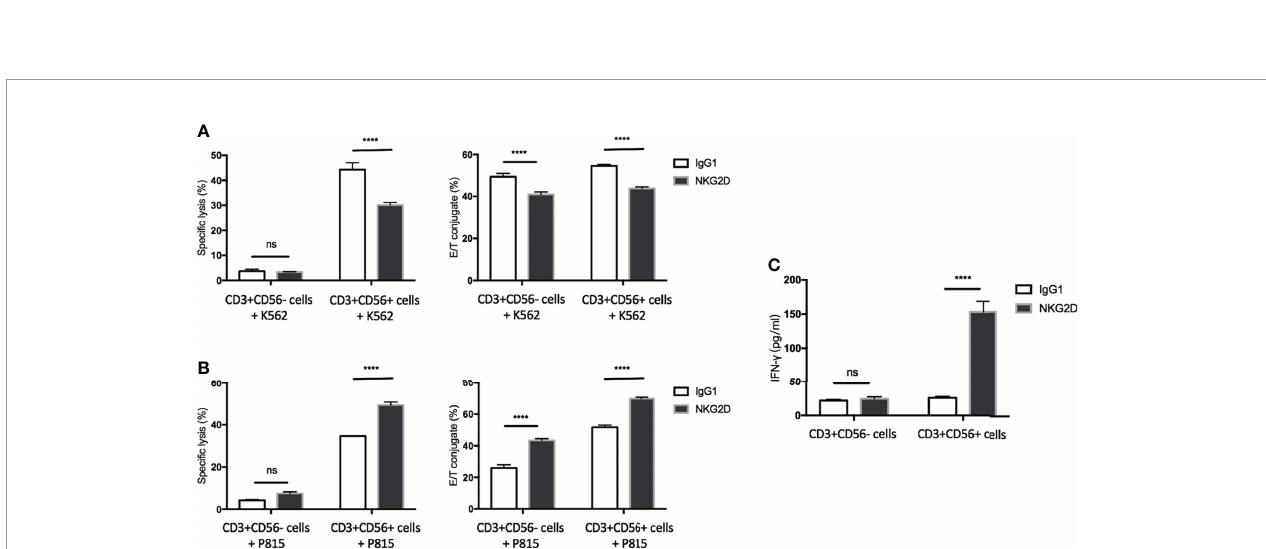
FIGURE 4 | NKG2D contributes alone to degranulation, IFN- g secretion, and LFA-1 activation, whereas 2B4 provides synergistic signals. (A) CIK cells were stimulated by indicated plate-bound antibodies (5 µg/ml) for 5 h in the presence of anti-CD107a-APC and GolgiStop, and the percentage of CD107a on CIK cells was determined by staining cells with anti-CD3-FITC and anti-CD56-PE. FACS dot plots showing the representative degranulation of different CIK subsets (within CD3+ gate) in response to IgG1 or NKG2D stimulation. (B) After 20 h of stimulation by indicated plate-bound antibodies (5 µg/ml), IFN- g was quanti fi ed using supernatant by sandwich ELISA. (C) CIK cells were unstimulated or stimulated with PMA or indicated antibodies in pairwise combination or combined with IgG1 isotype control. Following the cross-link of the receptors with goat F(ab)2 anti-mouse IgG, the activation of LFA-1 was measured by staining with ICAM-1 – Fc complexes. For gating out CIK subsets, cells were stained with anti-CD3-APC and anti-CD56-PE after ICAM-1 – Fc complexes staining. Dot plots showing the representative LFA-1 activation on different CIK subsets (within CD3+ gate) in response to indicated stimulations. The data are represented as mean ± SD of triplicates per condition and one representative of three independent experiments. ** p < 0.01, **** p < 0.0001, ns, not signi fi cant calculated by one-way ANOVA, Bonferroni ’ s post-hoc